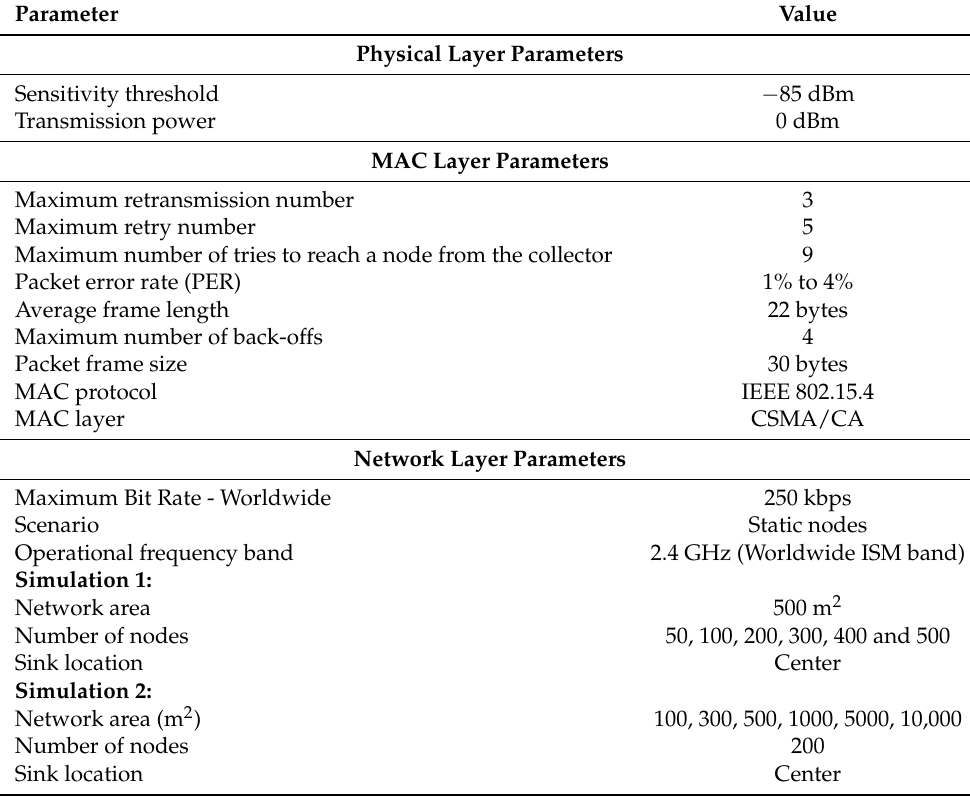
Table 4. Simulation parameters under CSMA/CA